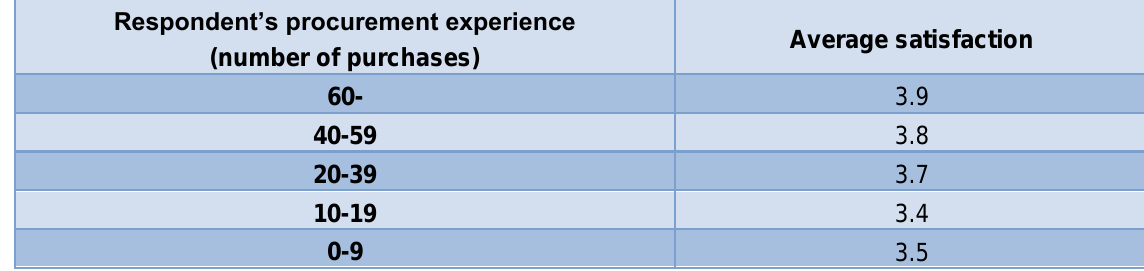
Table 8 Respondent‟s view of procurement procedures for complex projects (five-degree